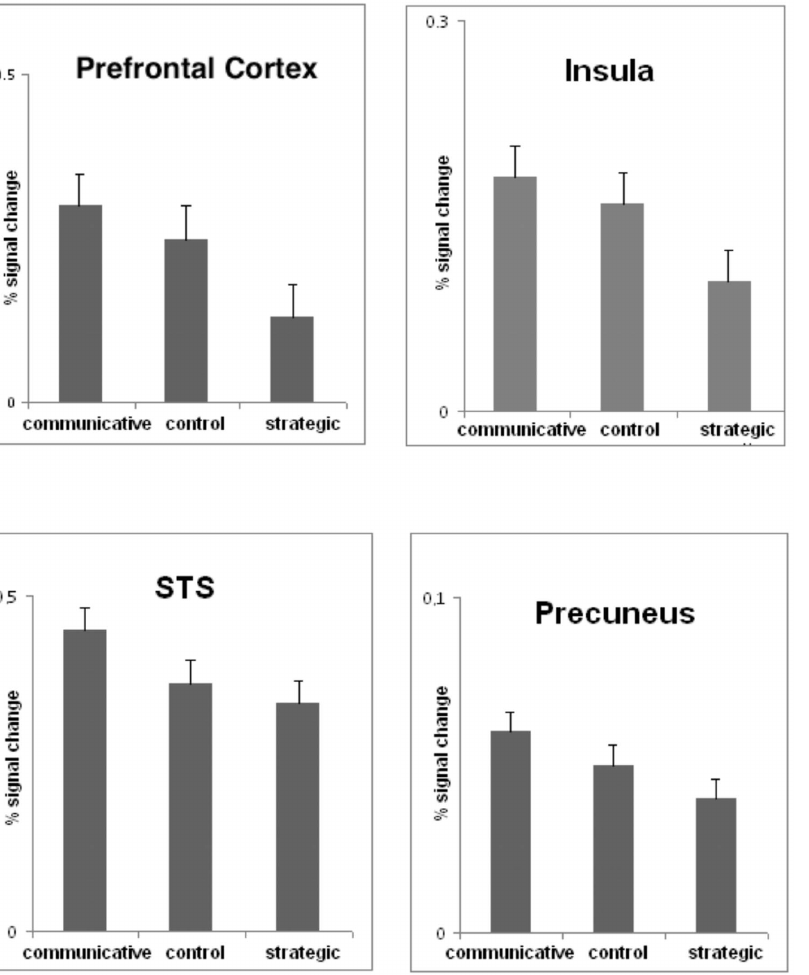
Figure 3. Signal changes of BOLD response relative to rest (with standard errors) for left prefrontal cortex (BA10, 2 24 52 32), right insula (34 22 0), left STS ( 2 52 2 42 2 2), and precuneus (22 2 58 28) (contrast communicative reasoning relative to strategic reasoning).